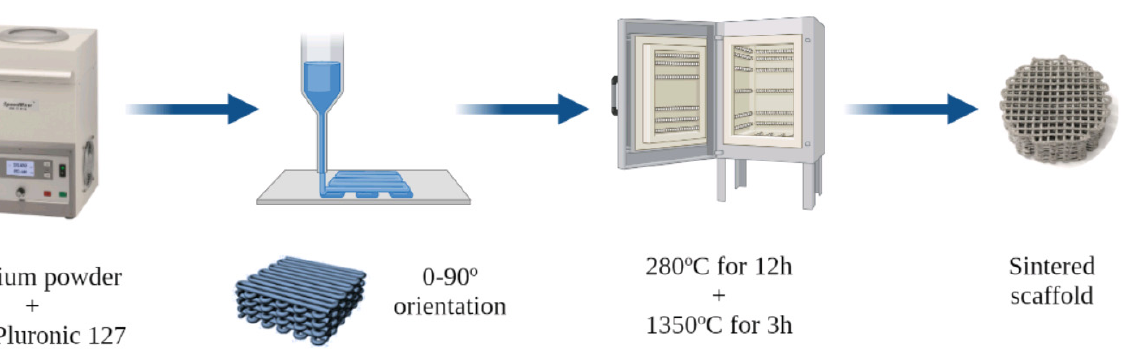
Figure 1. Schematic diagram of the 3D printing process of Ti scaffolds.